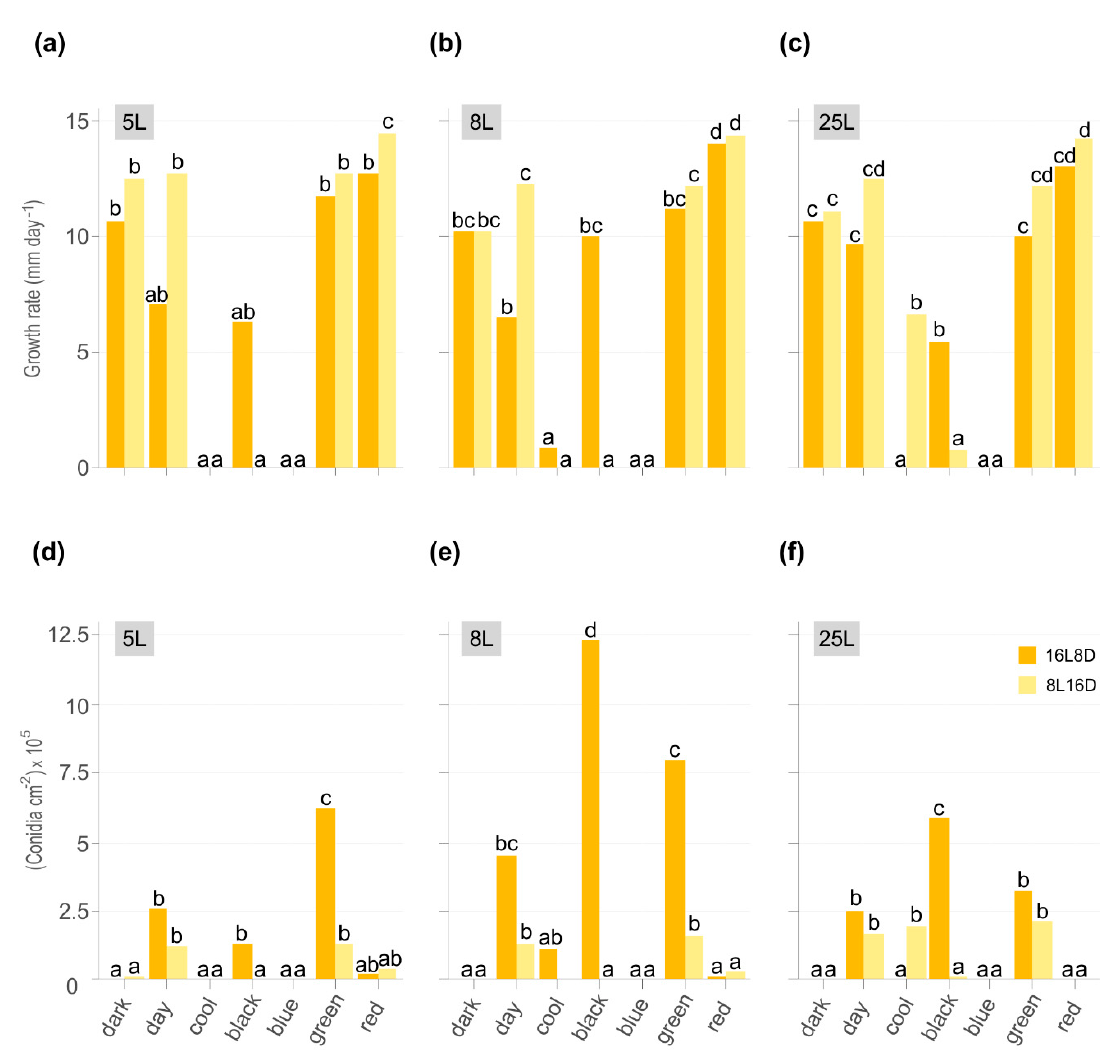
Figure 1. Effect of different light conditions on Monilinia laxa growth rate (mm day − 1 ) ( a – c ) and sporulation (conidia cm − 2 10 5 ) ( d – f ) on PDA-T plates inoculated with three M. laxa isolates: 5L ( a , d ), 8L ( b , e ), and 25L ( c , f ). All plates were incubated for 7 days under two white lights (daylight and cool) and black, blue, green, and red lights for photoperiods of 16 h light/8 h darkness (orange) and 8 h light/16 h darkness (yellow). As indicated in materials and methods, the continuous dark condition was subjected to both photoperiods. Data represent the average of two independent experiments, and letters denote significant differences according to the analysis of variance (ANOVA) to Duncan’s multiple range test.